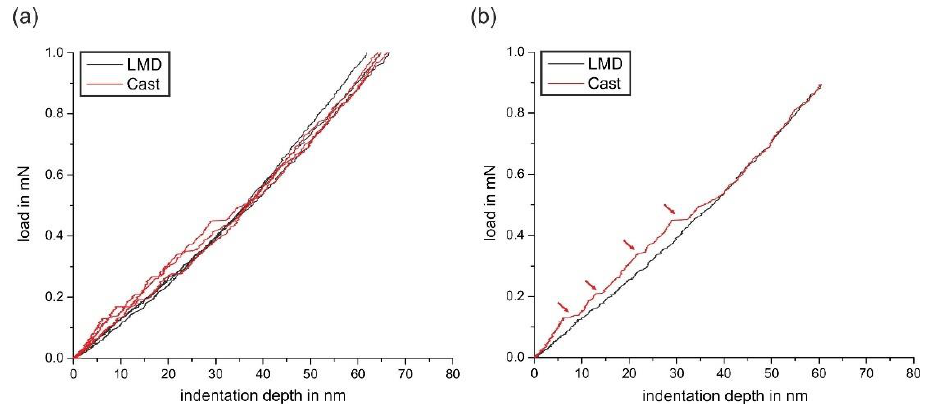
Figure 17. ( a ) Several load-displacement curves measured in the LMD and Cast specimens, and ( b ) one selected curve of both specimens for better comparison. At the beginning of the curve, pronounced pop-ins are visible in the case of the specimen cast.